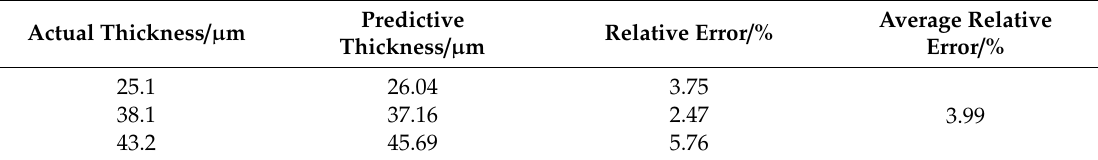
Table 7. The output results of the calculation model by principal component analysis (PCA)-RBF neural